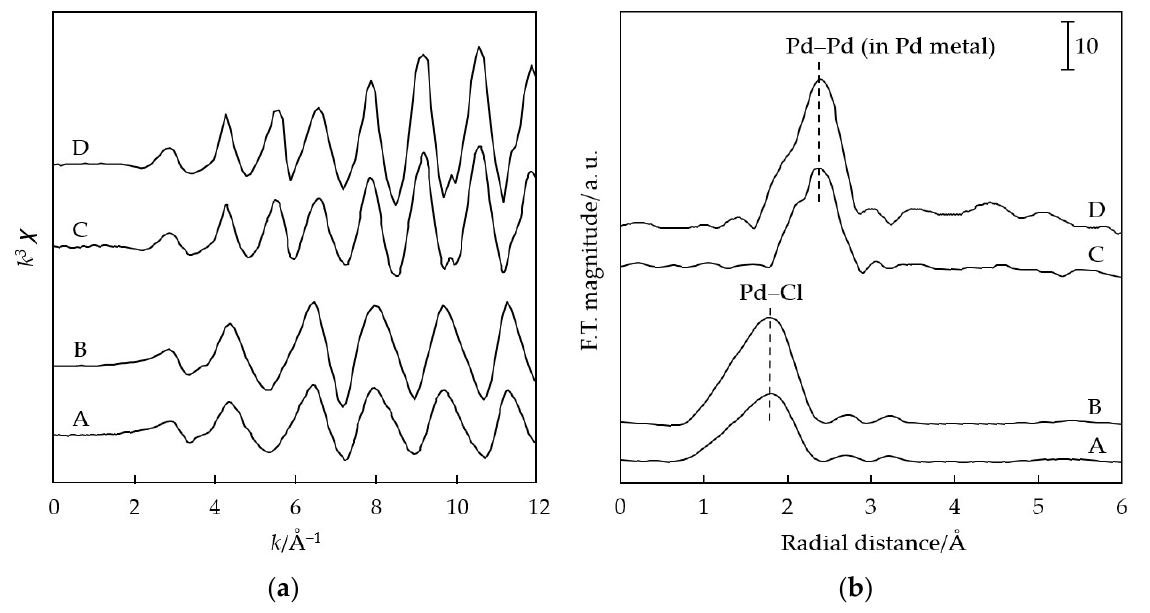
Figure 7. EXAFS functions of various samples. ( a ) Pd K-edge k 3 -weighted EXAFS spectra and ( b ) magnitude of Fourier transforms in the r -space. (A): Pd-PW-HAP before reaction; (B): PdCl 2 ; (C): Pd-PW-HAP after reaction at 363 K for 8 h; (D): Pd foil. A reduced factor of 0.5 was applied for Pd foil.